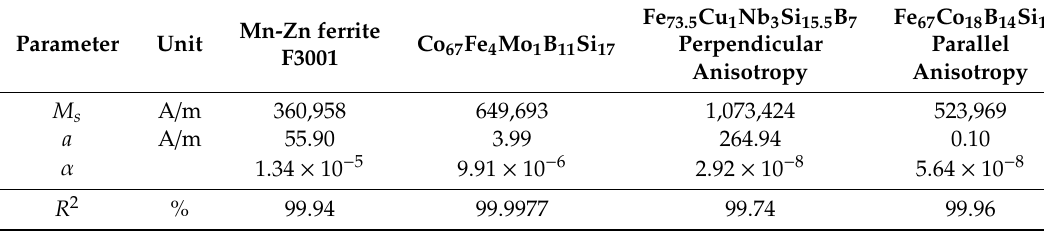
Table 2. Parameters of anhysteretic curve exp-based model identified during the optimization process.